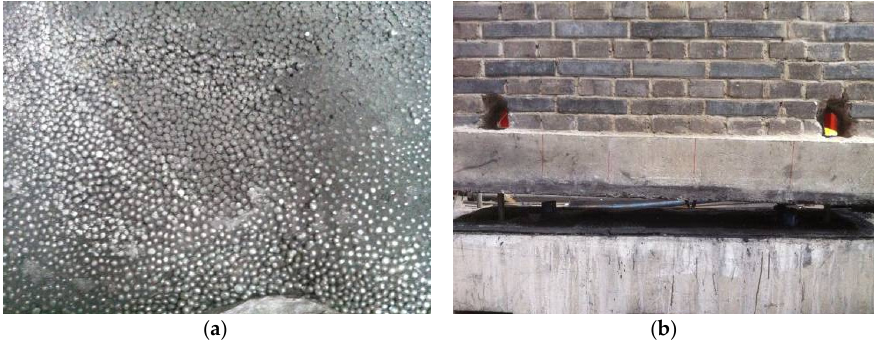
Figure 8. MG isolator: ( a ) MG mixture; ( b ) MG isolator in place. Tables 1 and 2 present the main characteristics of the marbles and graphite.